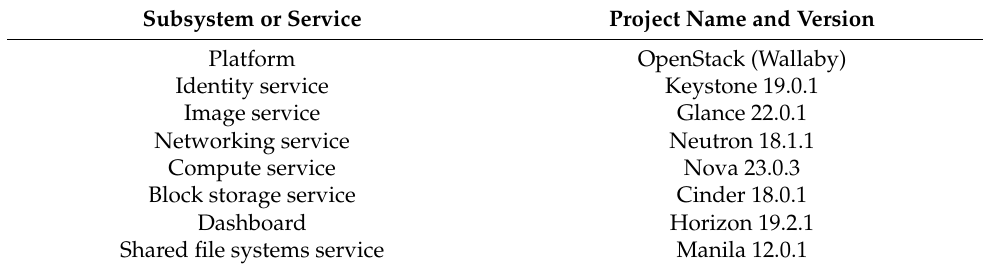
Table 1. OpenStack components as IaaS used in this